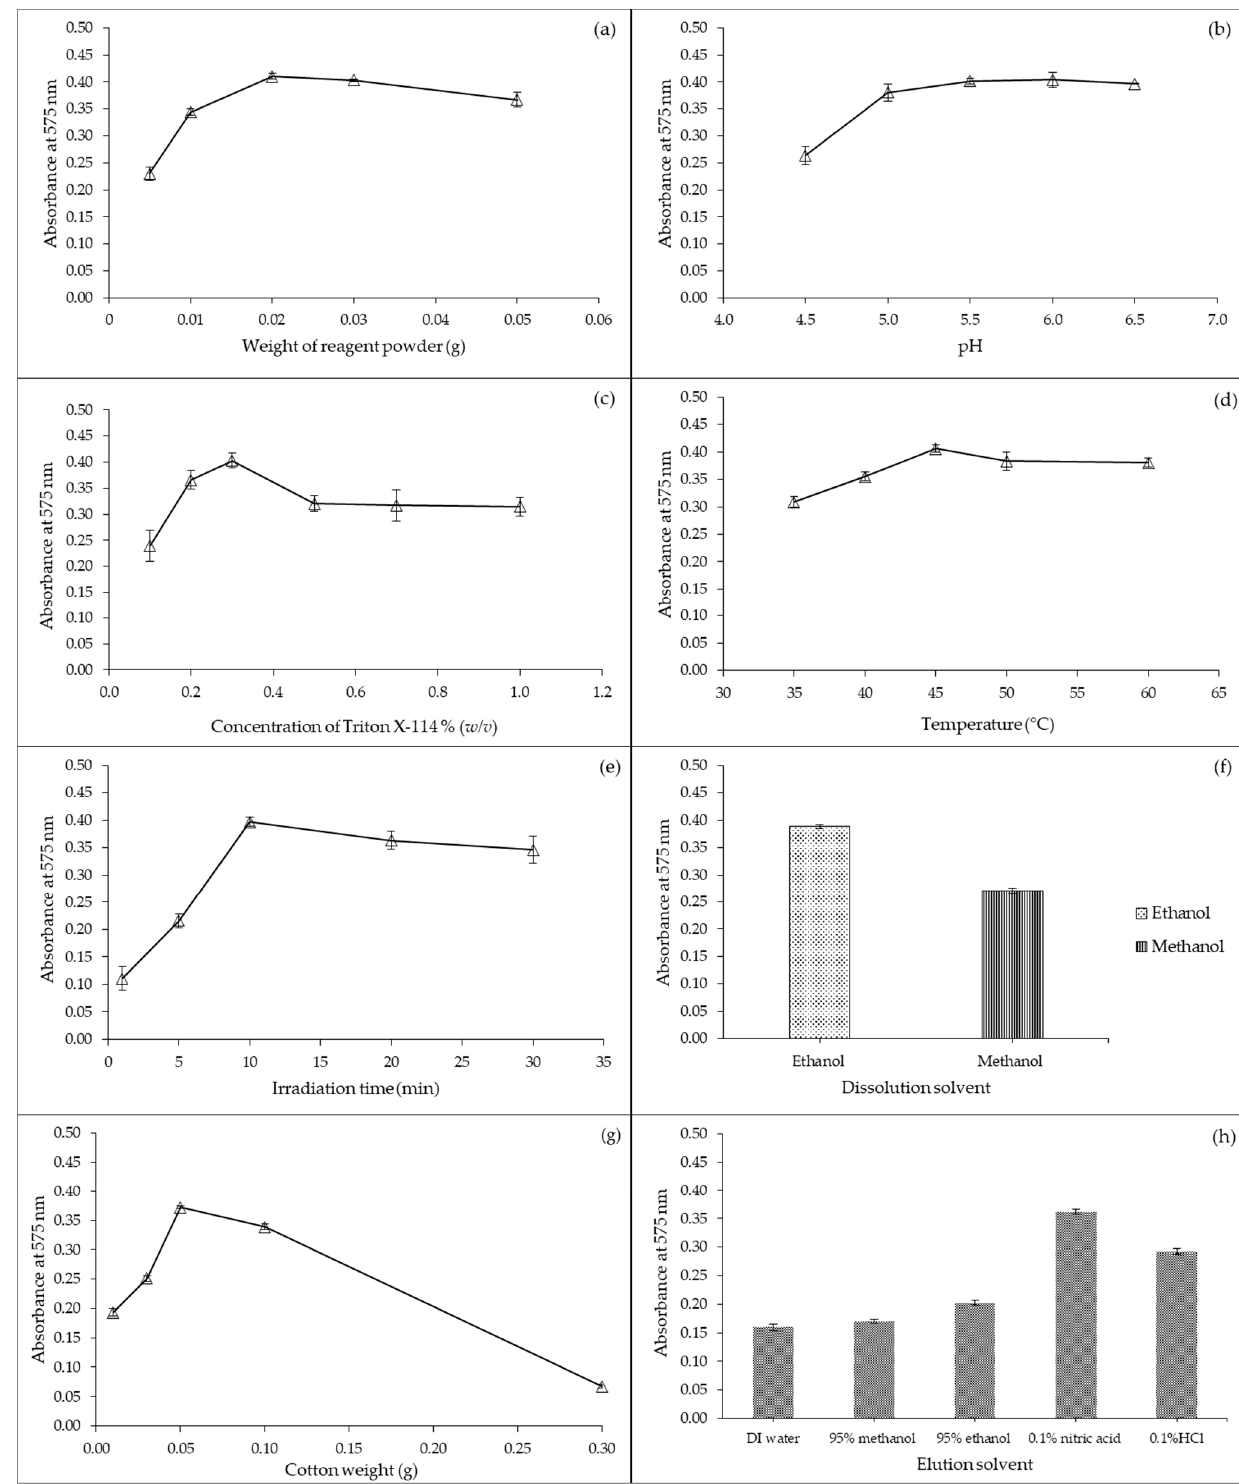
Figure 4. Optimal conditions of various parameters on sensitivity for the determination of total iron by the developed method at maximum wavelength 575 nm; ( a ) Effect of amount of Dipterocarpus intricatus Dyer fruit powder; ( b ) Effect of pH; ( c ) Effect of Triton X-114 concentration; ( d ) Effect of temperature; ( e ) Effect of ultrasonic irradiation; ( f ) Effect of dissolution solvent; ( g ) Effect of cotton weight and ( h ) Effect of elution solvent.